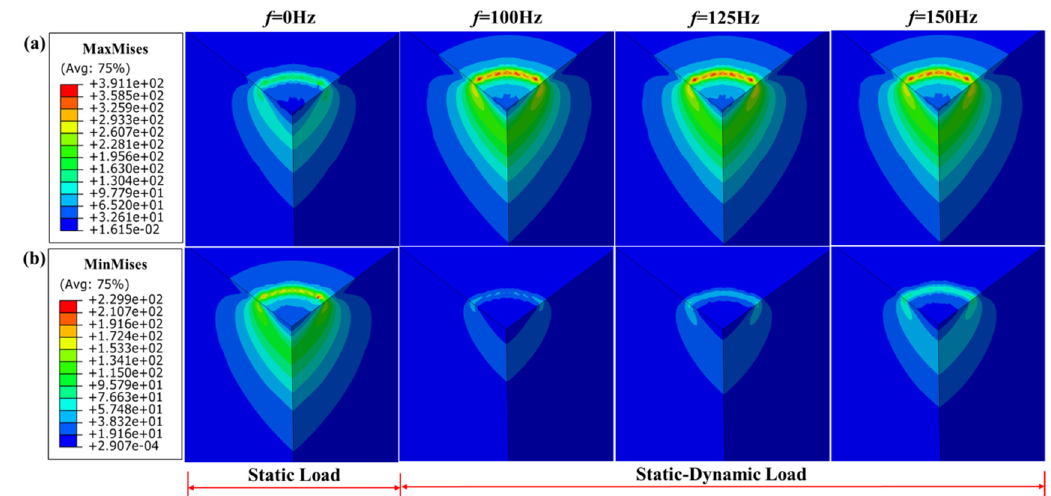
Figure 10. The comparison of Mises stress contour plots under static and static-dynamic loads with different frequencies of dynamic load for cylindrical indenter: ( a ) MaxMises. ( b ) MinMises.